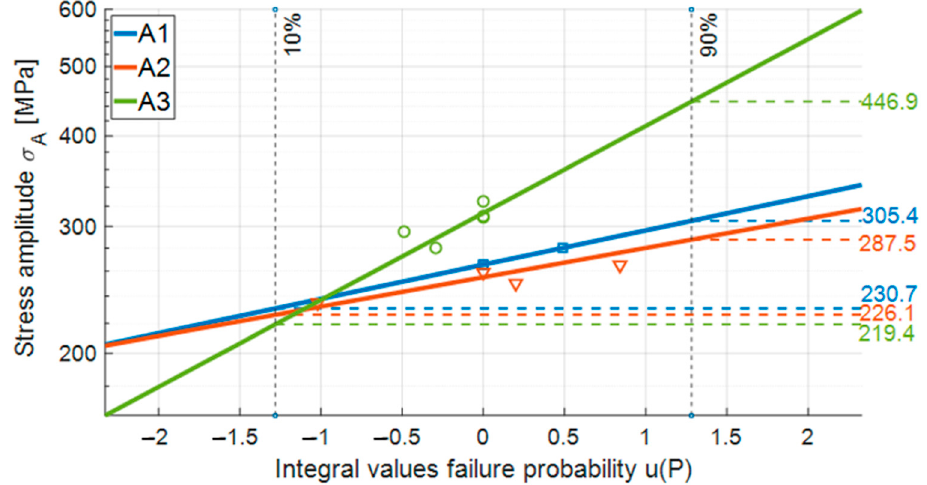
Figure 5. Probability mesh in transition zone of rotating bending fatigue testing of alloys A1 (0 wt.% Al), A2 (0.33 wt.% Al) and A3 (0.18 wt.%